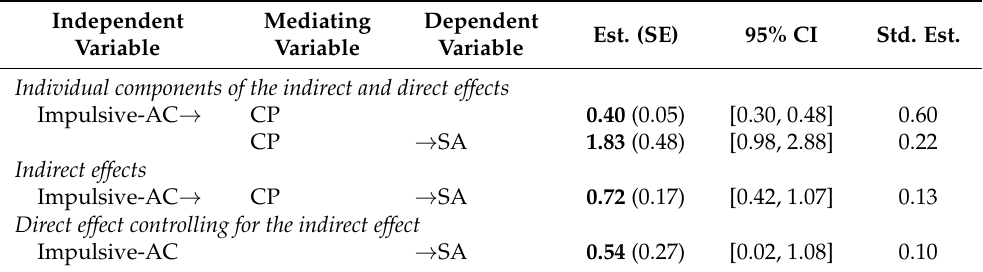
Table 3. Results of the Mediation Analysis for Impulsive-Appetitive Cyberaggression: Indirect and Direct Effect.